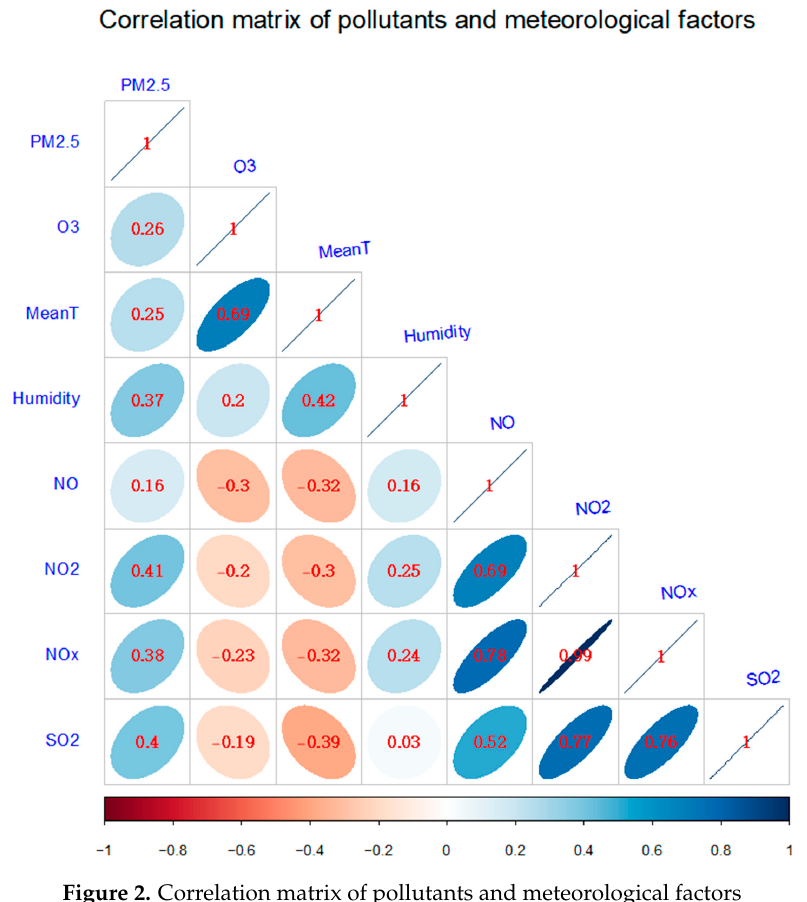
Figure 2. Correlation matrix of pollutants and meteorological factors